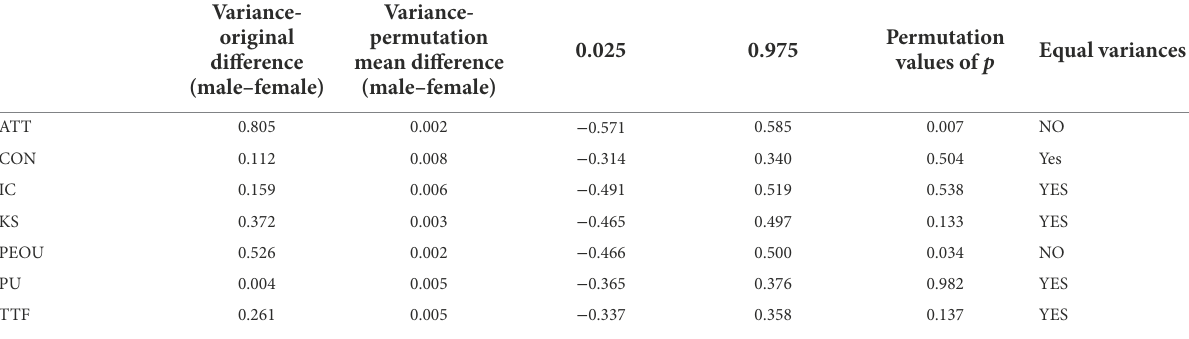
TABLE 12 MICOM step 3 results report—part 2.